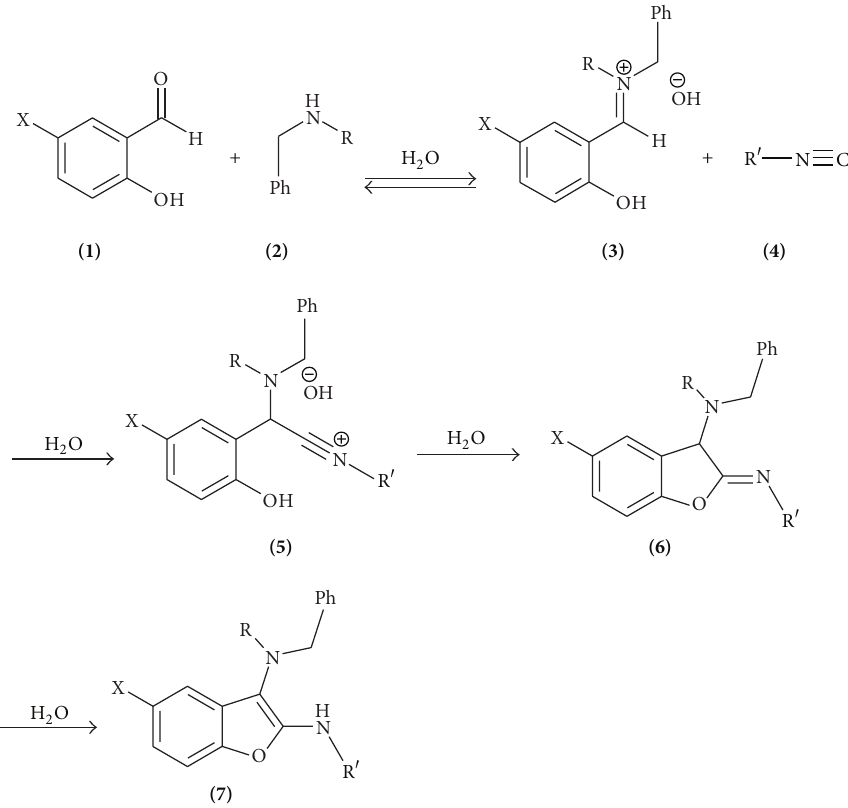
Figure 2: Proposed mechanism for the formation of benzo[ b ]furan derivatives, 7a-i , in